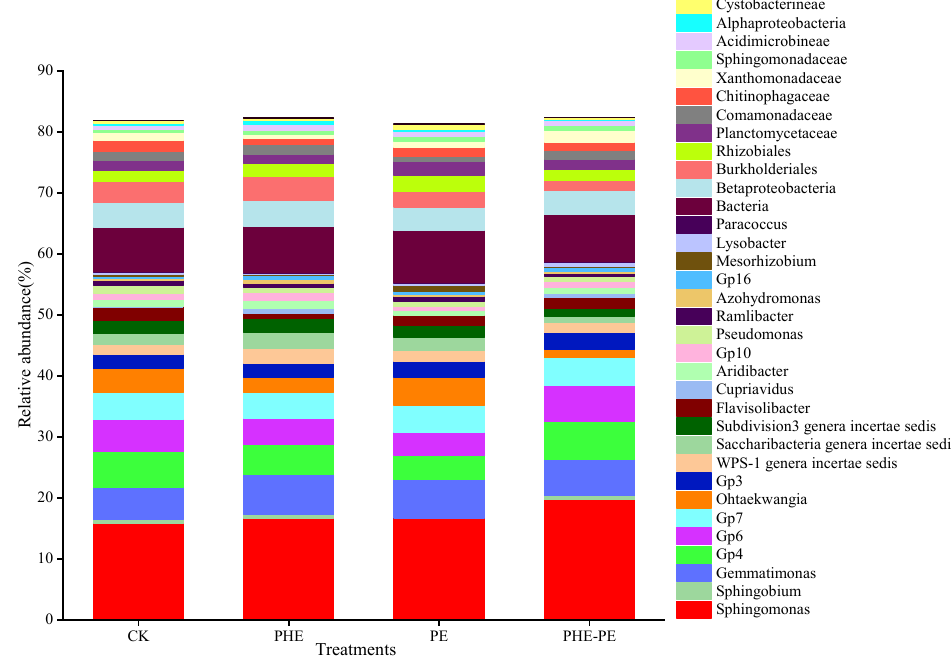
Figure 1. Relative abundance of the microbial communities in the different treatments at genus level.